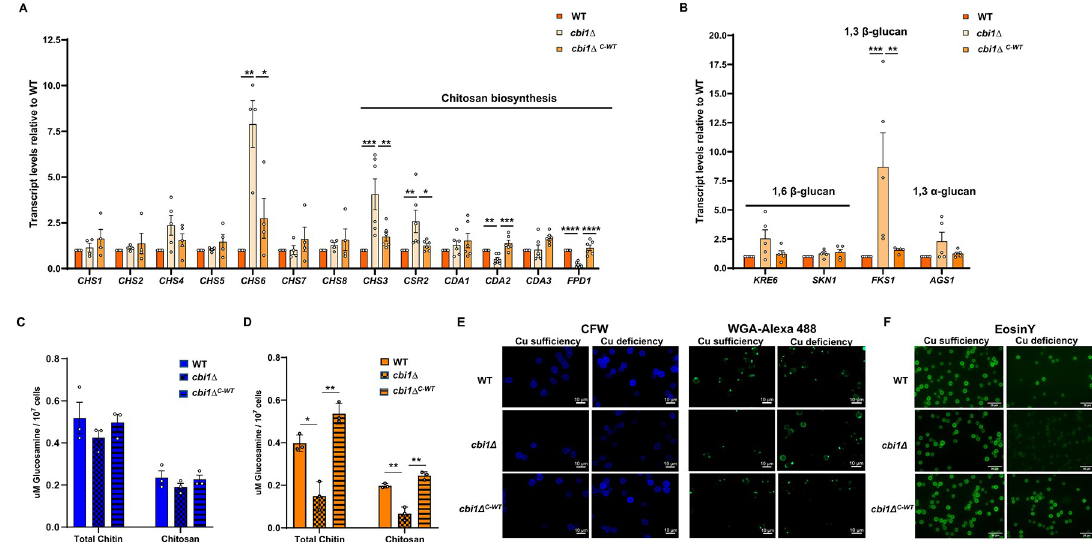
Fig 4. Cbi1-dependent cell wall gene transcript abundance and cell wall chitosan levels. (A)-(B) The WT, cbi1 Δ mutant, and cbi1 Δ C-WT complemented strains were incubated in YPD supplemented with 250 μ M BCS for 24h at 30˚C. Relative transcript abundance for cell wall genes involved in (A) chitin/chitosan synthesis or (B) glucan synthesis was assessed by quantitative RT-PCR and normalized to WT. Presented data is the mean +/- SEM of the relative transcript levels of 4 biological replicates. A 1-way ANOVA was performed from log transformed data using GraphPad Prism. (C)-(D) Chitin/chitosan quantification of copper sufficient (C) or deficient (D). The WT, cbi1 Δ mutant, and cbi1 Δ C- WT complemenbted strains were incubated for 24h in YPD+ 10 uM CuSO4 (copper sufficiency) or YPD +250 uM BCS (copper deficiency). MBTH-based chitin/chitosan quantification ( μ M glucosamin/10 7 cells) was performed for purified cell wall material. Data represent the mean +/- SEM of 3 biological replicates. A 1-way ANOVA was performed from log transformed data using GraphPad Prism. (E) The same strains incubated in identical conditions above were also assessed for chitin and chitosan by staining with calcofluor white (CFW) (total chitin/chitosan), wheat germ agglutin (WGA)-Alexa 488 (exposed chitin/chitosan), and (F) Eosin Y (chitosan). Representative images from at least three independent experiments are